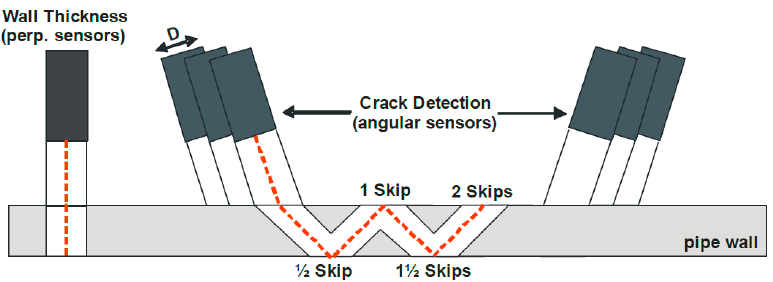
Figure 12. Principle of sensors in ultrasonic inspection equipment.